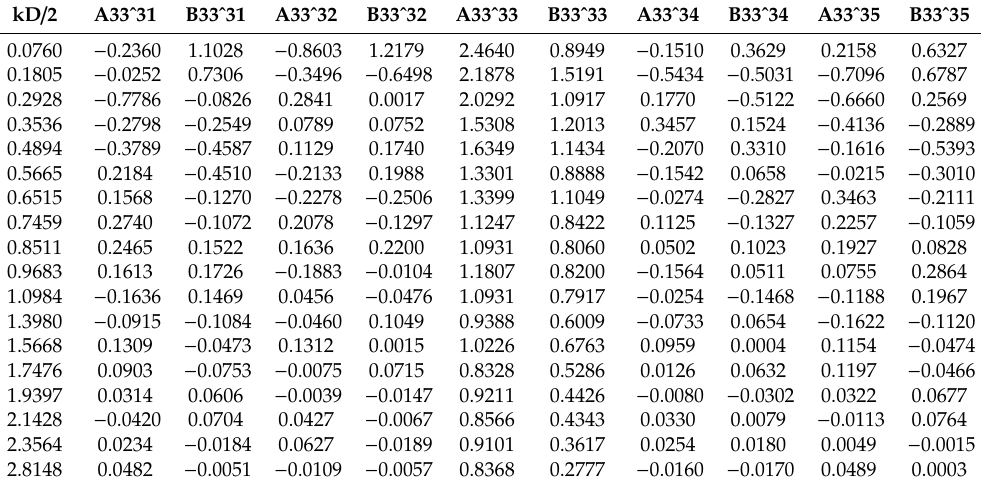
Table A1. Hydrodynamic characteristics of the 3rd floater of the array of five conical floaters.